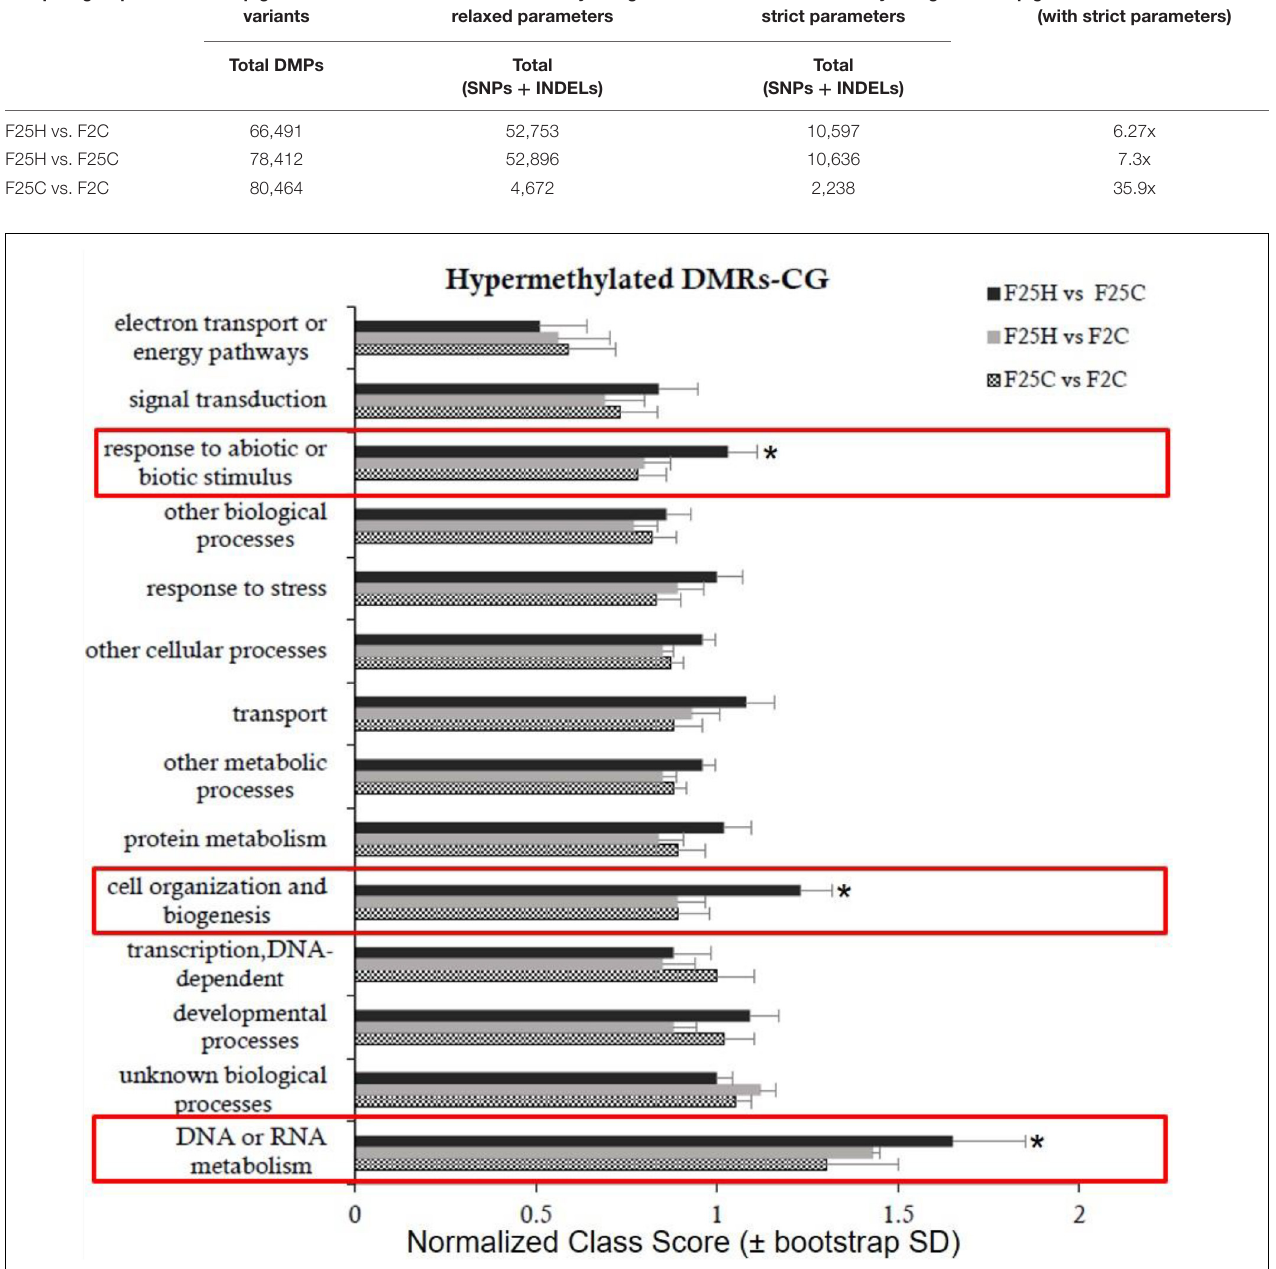
TABLE 1 | Comparison of epigenetic and genetic variations in F25H, F25C, and F2C plants. Samples group